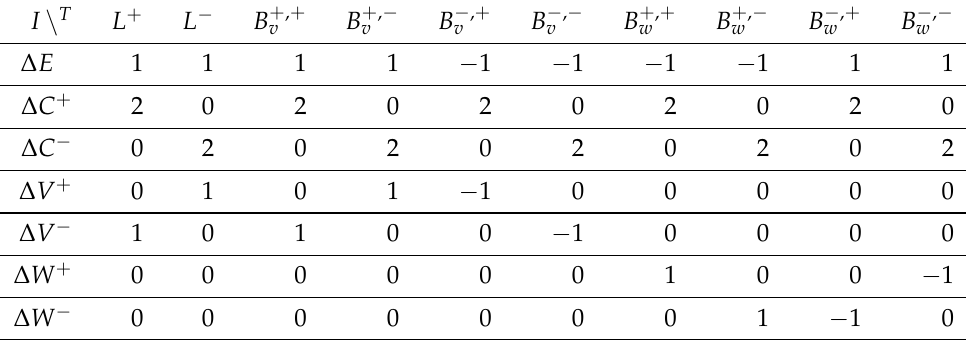
Figure 8. Local effect: decomposition of the beaks transitions. Table 1. Local effect: decomposition of the beaks